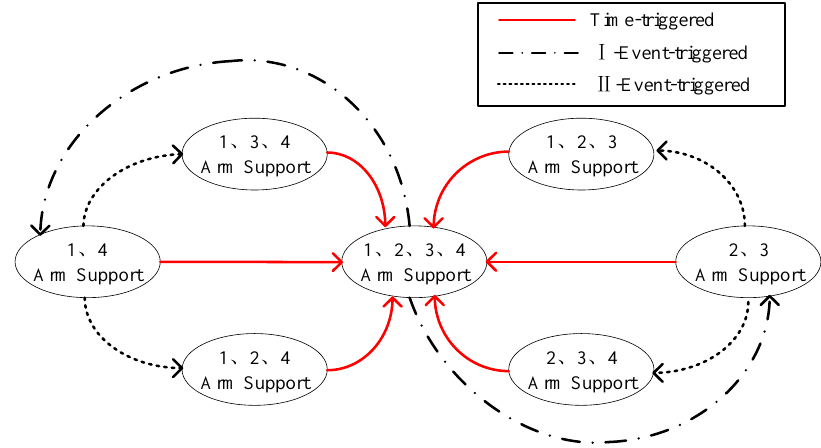
Figure 5. Event-triggered hybrid triggers. The numbers are manually calibrated to facilitate the description of relative positional relationships, Details are in Figure